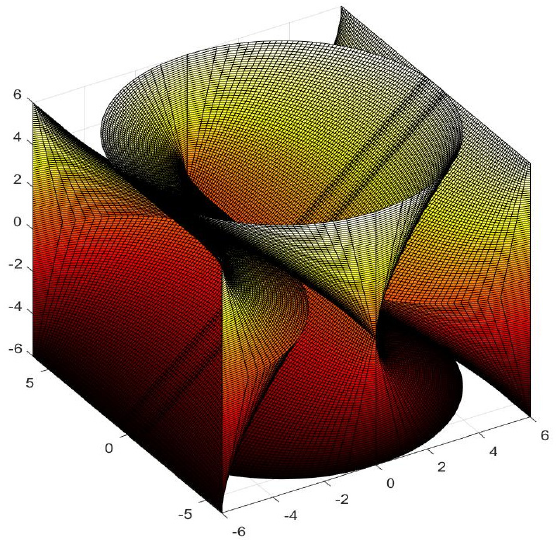
Figure 14. The Figure 14. The Alopshera. Figure 14. The Alopshera.